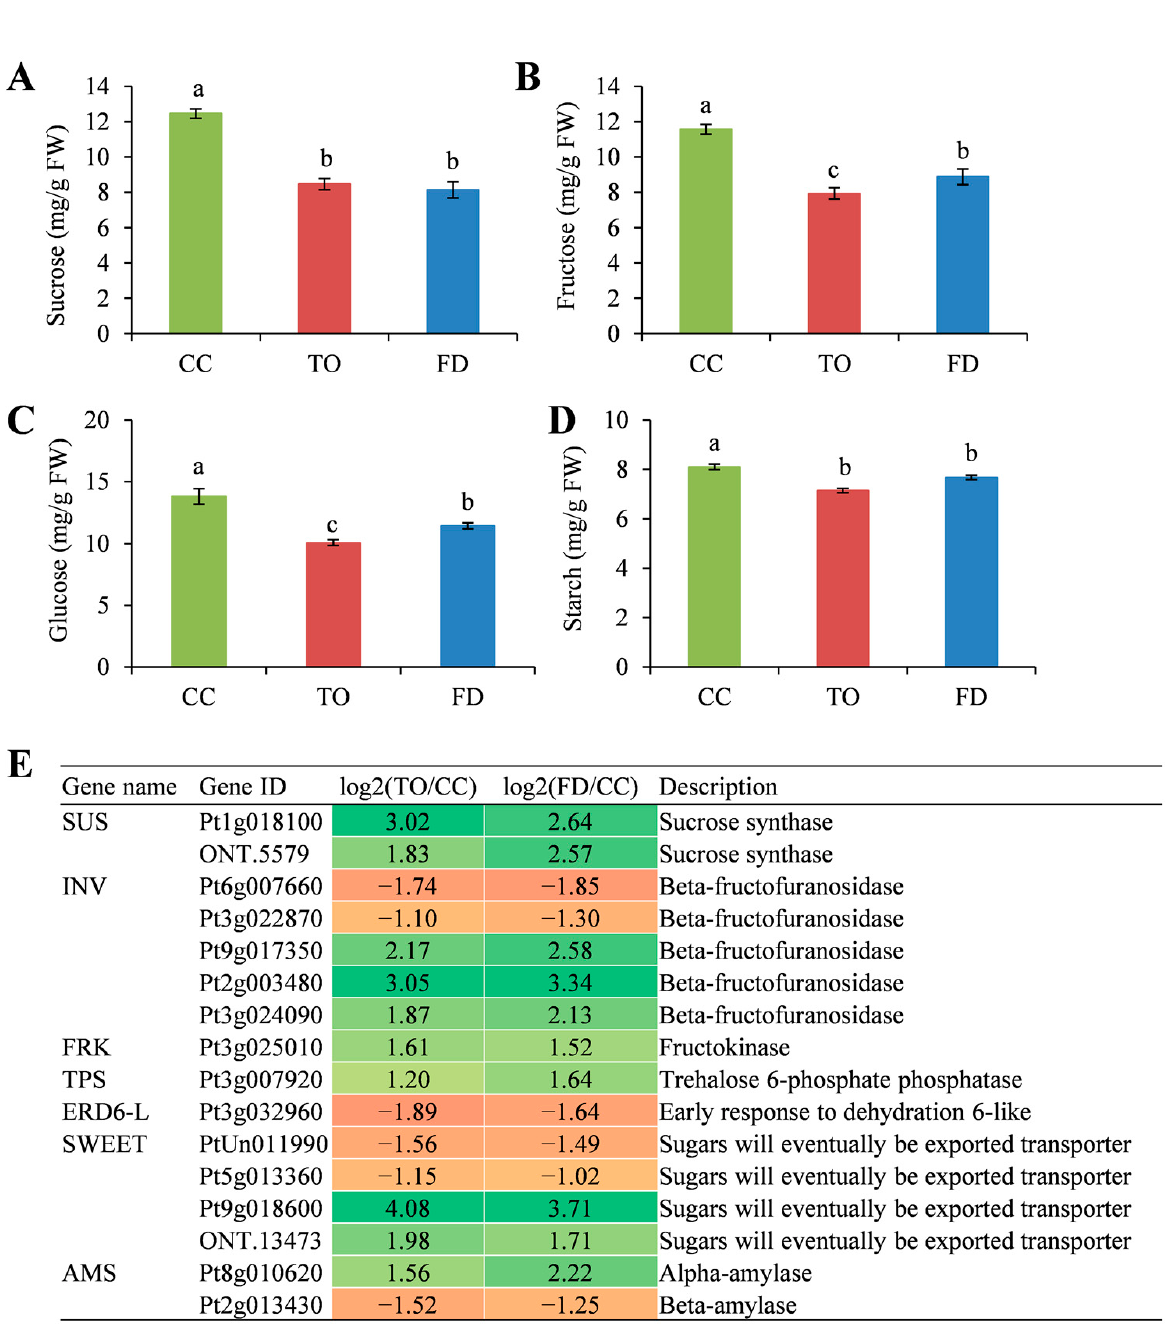
Figure 5. Changes in the content of sucrose ( A ), fructose ( B ), glucose ( C ), starch ( D ), and their metabolism-related gene expression ( E ). Different small letters indicate significant differences at p < 0.05 according to Duncan’s multiple range tests.